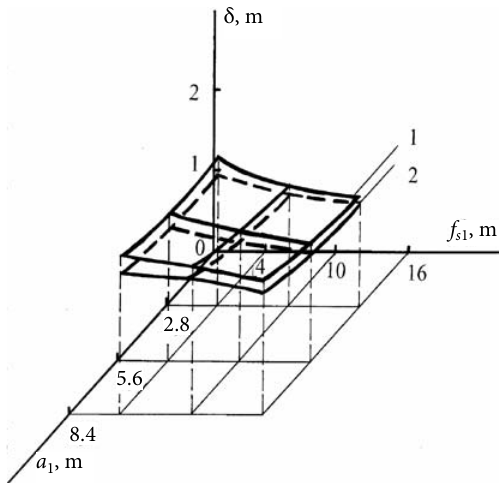
Fig. 9. Max vertical displacements δ vs the initial deflection f s 1 of cable truss top chord and distance a 1 between the support points of tie-bars: 1– displacements of the cable net at the support points are restricted by the guys deformations; 2 – the support points of the cable net are fixed The dependence shows, that the min values of vertical displacements of cable net were obtained, when the initial deflection of cable truss top chord was equal to 16 m and the distance between the nodes of the cable truss was equal to 2.8 m for both variants of support points fixation. The dependence of the effectiveness of cable net ma- terials using for max vertical displacements decrease on the initial deflection of cable truss top chord and distance between the cable truss nodes is shown in Fig. 10.